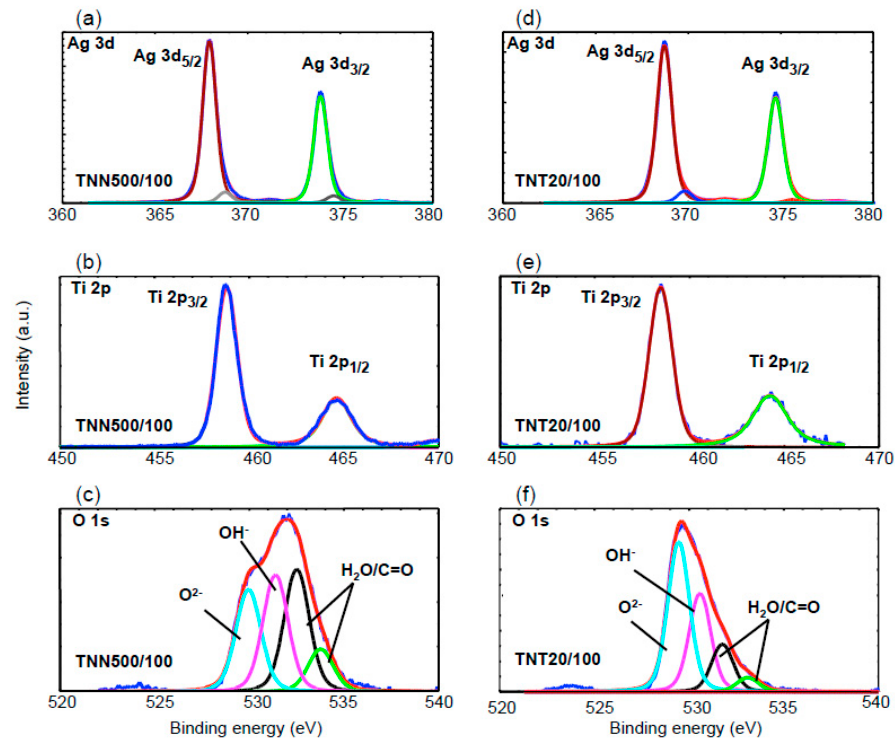
Figure 4. XPS spectra of TNT/Ag and TNN/Ag coatings; ( a , d ) Ag 3d, ( b , e ) Ti 2p peaks, and ( c , f ) O 1s peaks.